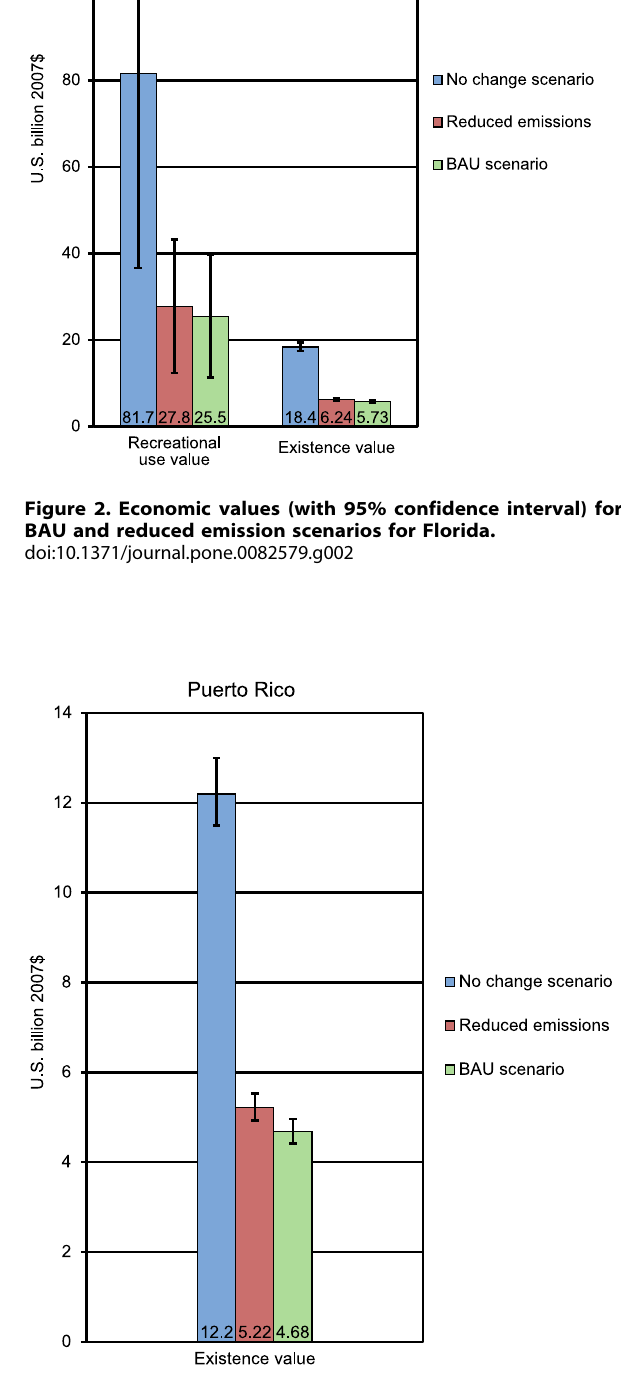
Figure 3. Economic values (with 95% confidence interval) for BAU and reduced emission scenarios for Puerto Rico.